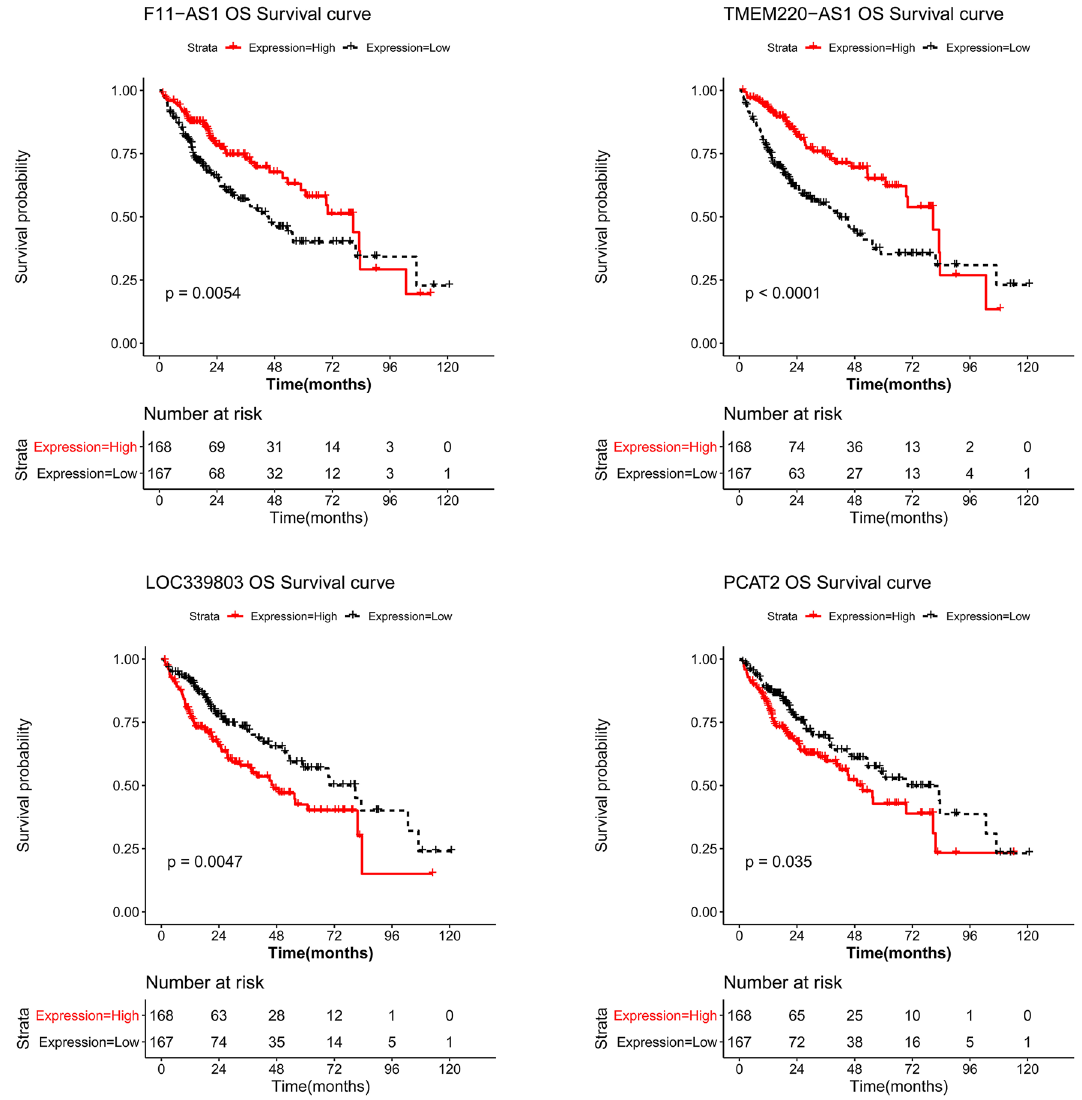
Figure 6. Kaplan–Meier survival analysis of four lncRNAs in the